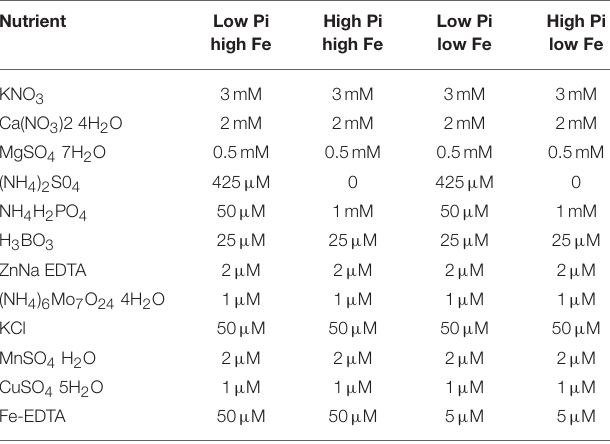
TABLE 1 | Table showing concentrations of different nutrient components used in low Pi high Fe, high Pi high Fe, low Pi low Fe, and high Pi low Fe media preparations used for low and high P/low and high Fe treatments.